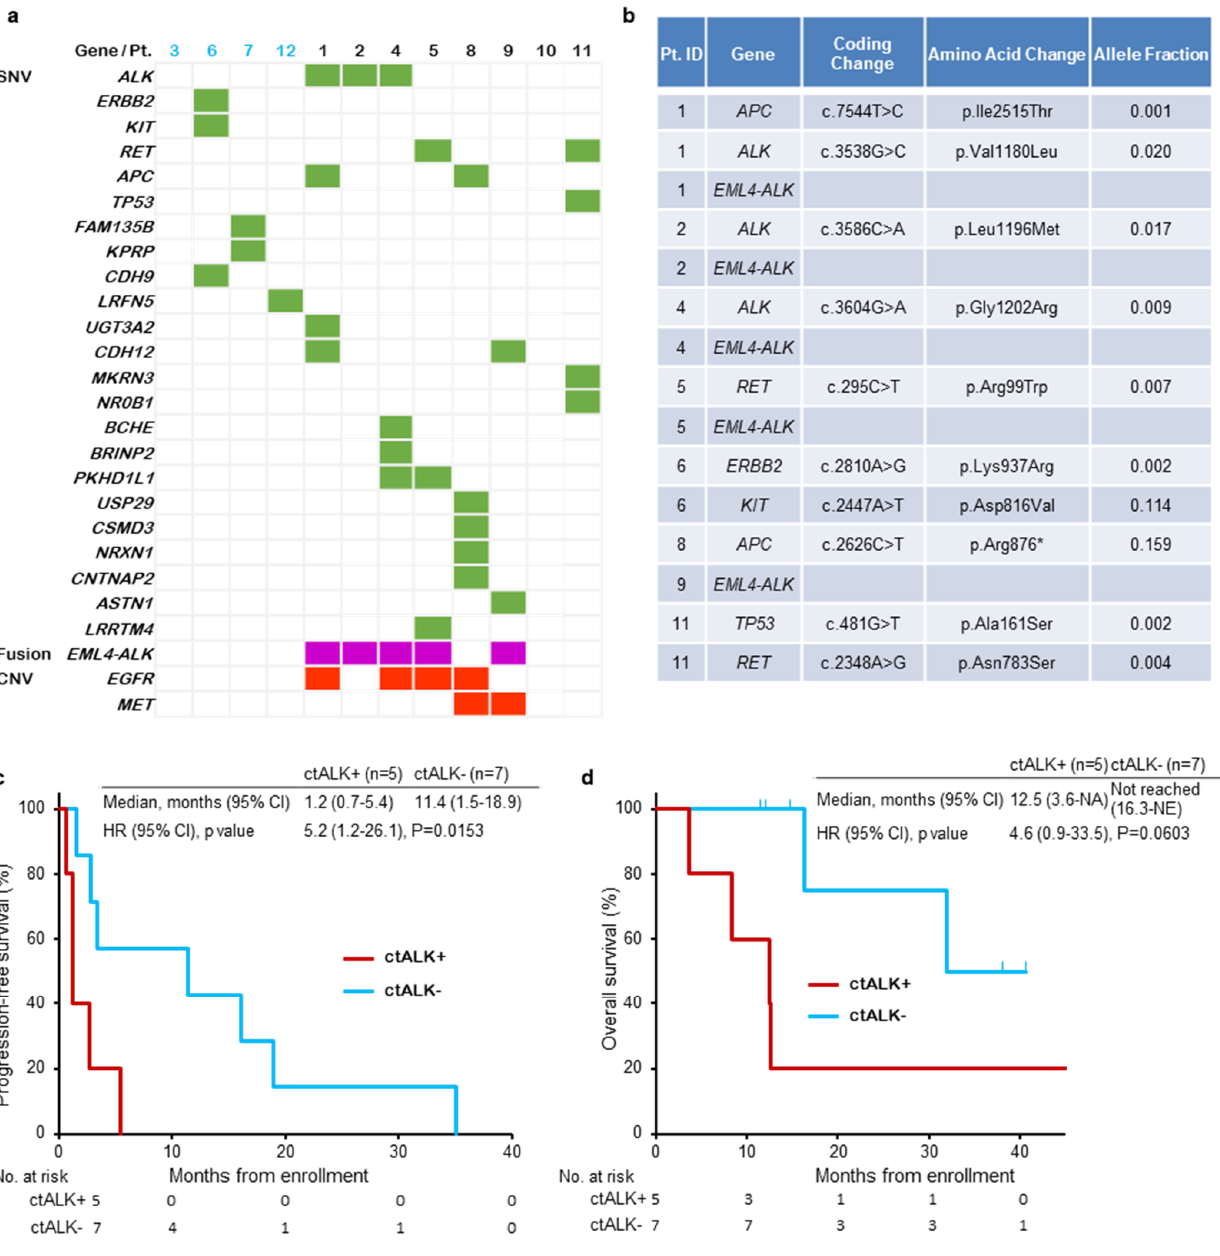
Figure 3. Predictive biomarker analysis using ctDNA. ( a ) Gene mutations and fusion genes detected in individual patients are shown. ( b ) Analysis focused on mutations associated with NSCLC. Kaplan–Meier curves for progression-free survival ( c ) and overall survival ( d ) among patients with or without the EML4-ALK fusion gene in ctDNA. SNV; single nucleotide variant, CNV; copy number variant, ctALK; circulating tumor anaplastic lymphoma kinase fusion gene, NE; not evaluable.